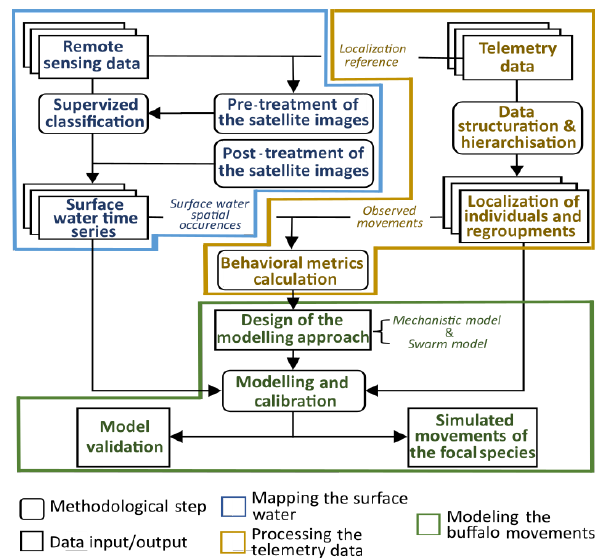
Figure 2. Flowchart combining remote sensing data with telemetry data to model the focal species